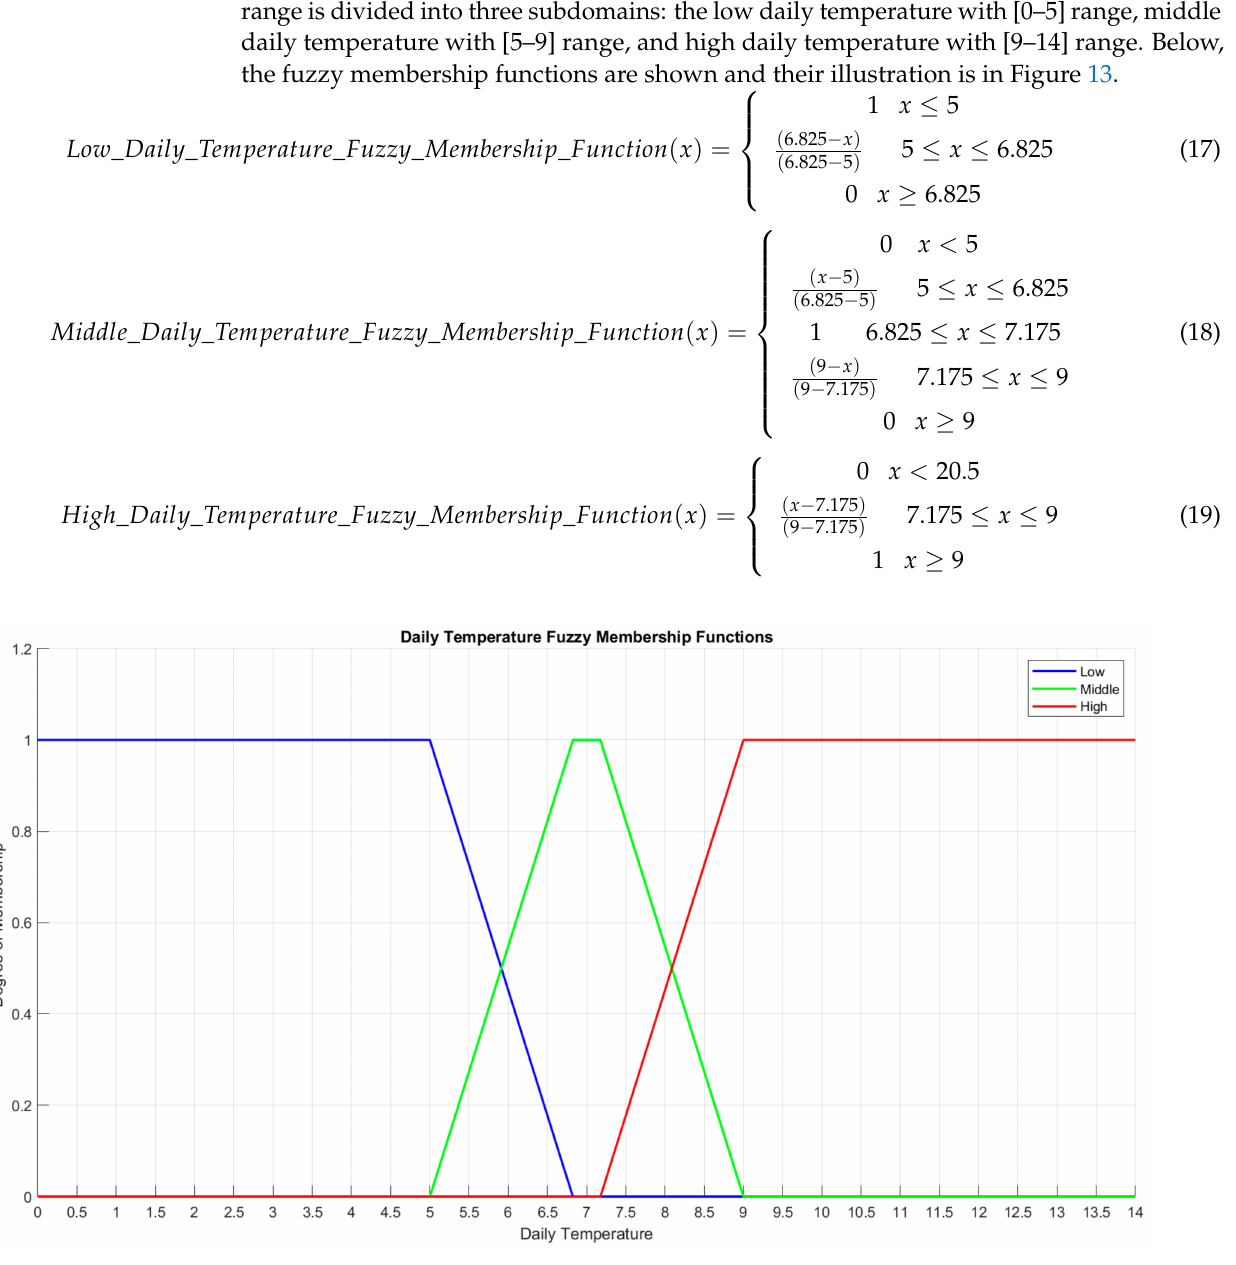
Figure 13. Daily temperature fuzzy membership